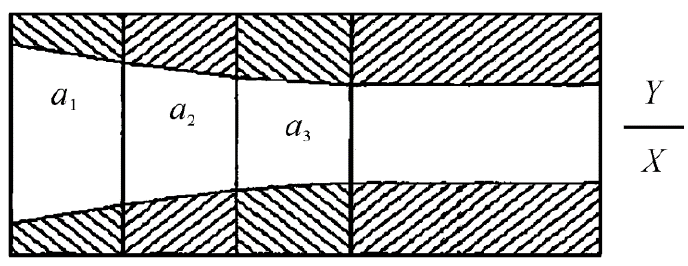
Figure 11. Structure of three-taper combined dies. Adapted with permission from Ref. [140]. 2020, Journal of Chongqing University of Technology.